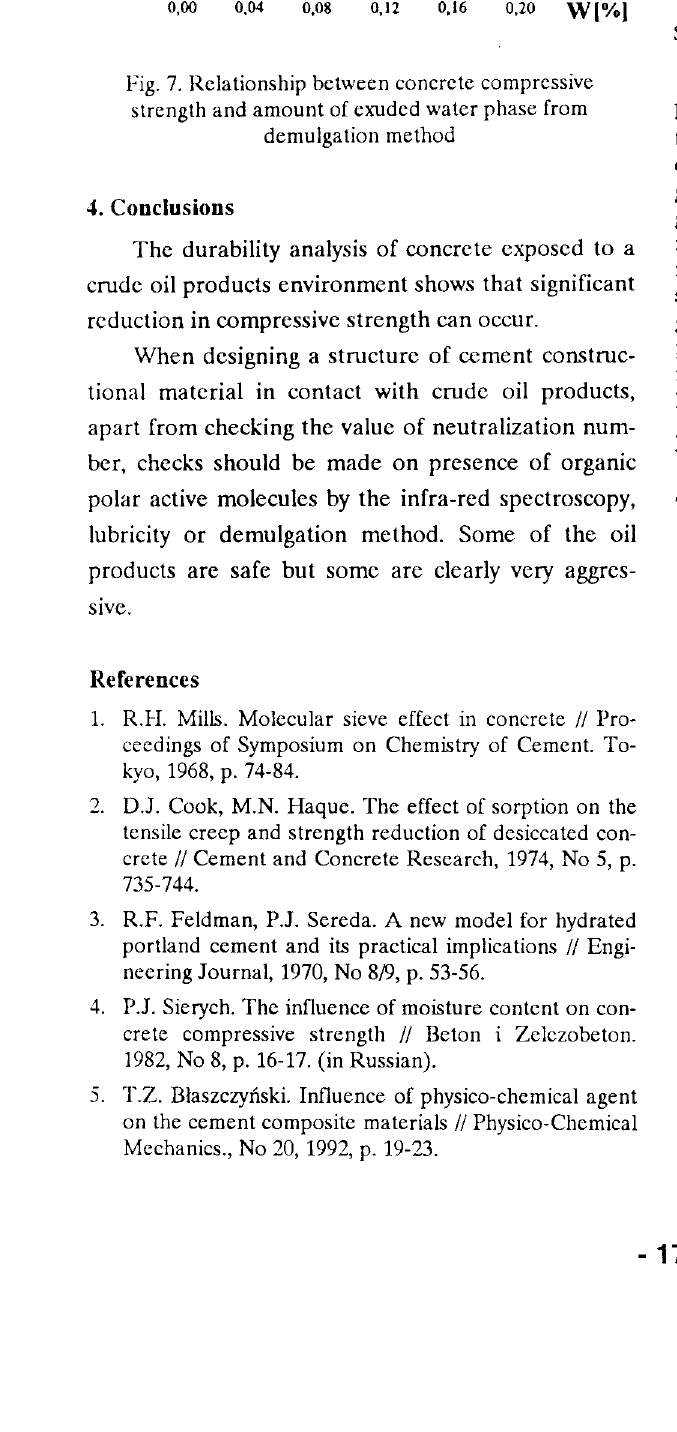
Fig. 7. Relationship between concrete compressive strength and amount of exuded water phase